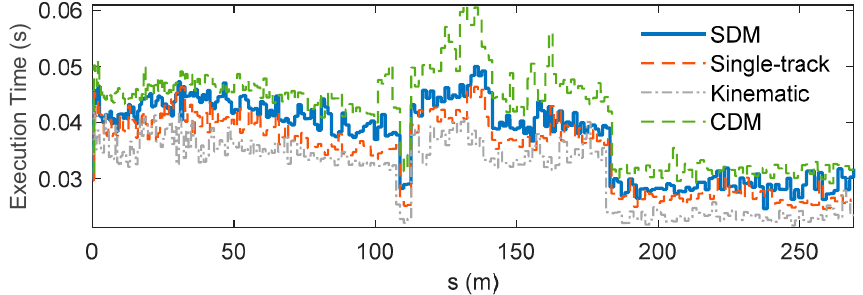
Figure 12. Execution time of nonlinear model predictive control theory (NMPC).